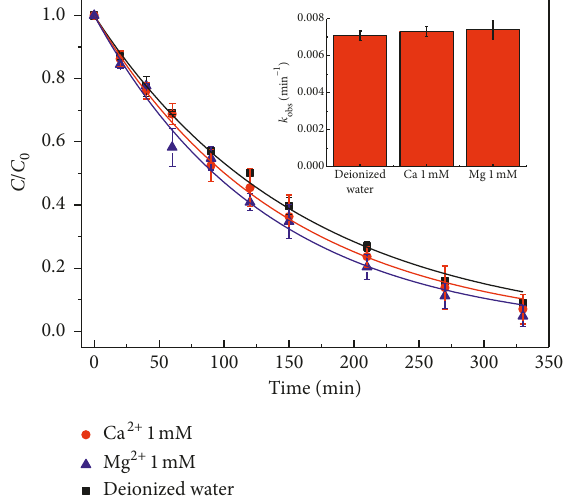
Figure 9: Effects of dissolved oxygen on AMO degradation by TAP. Solid lines represent the pseudo-first-order kinetic model fits. Insert: changes of k obs at different conditions. Experimental con- ditions: [AMO] 0 � 0.1 mM; [PS] 0 � 10 mM; T � 50 ° C; reaction time � 330min.